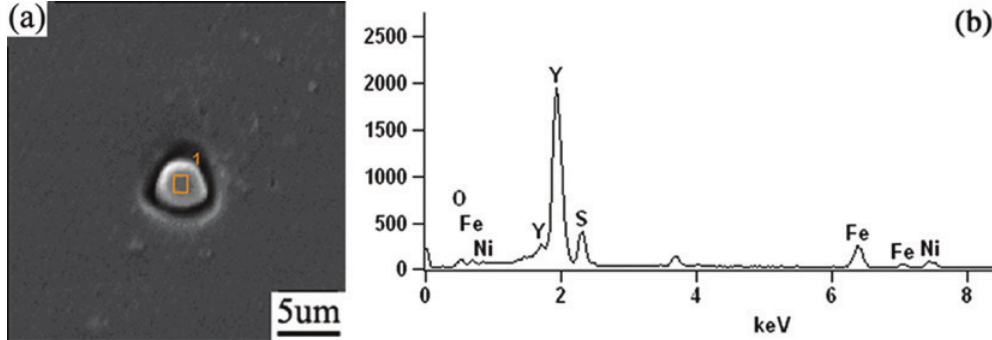
Fig. 3: SEM morphology and EDS analysis of the typical Y 2 O 2 S particle. (a) SEM morphology; (b) EDS